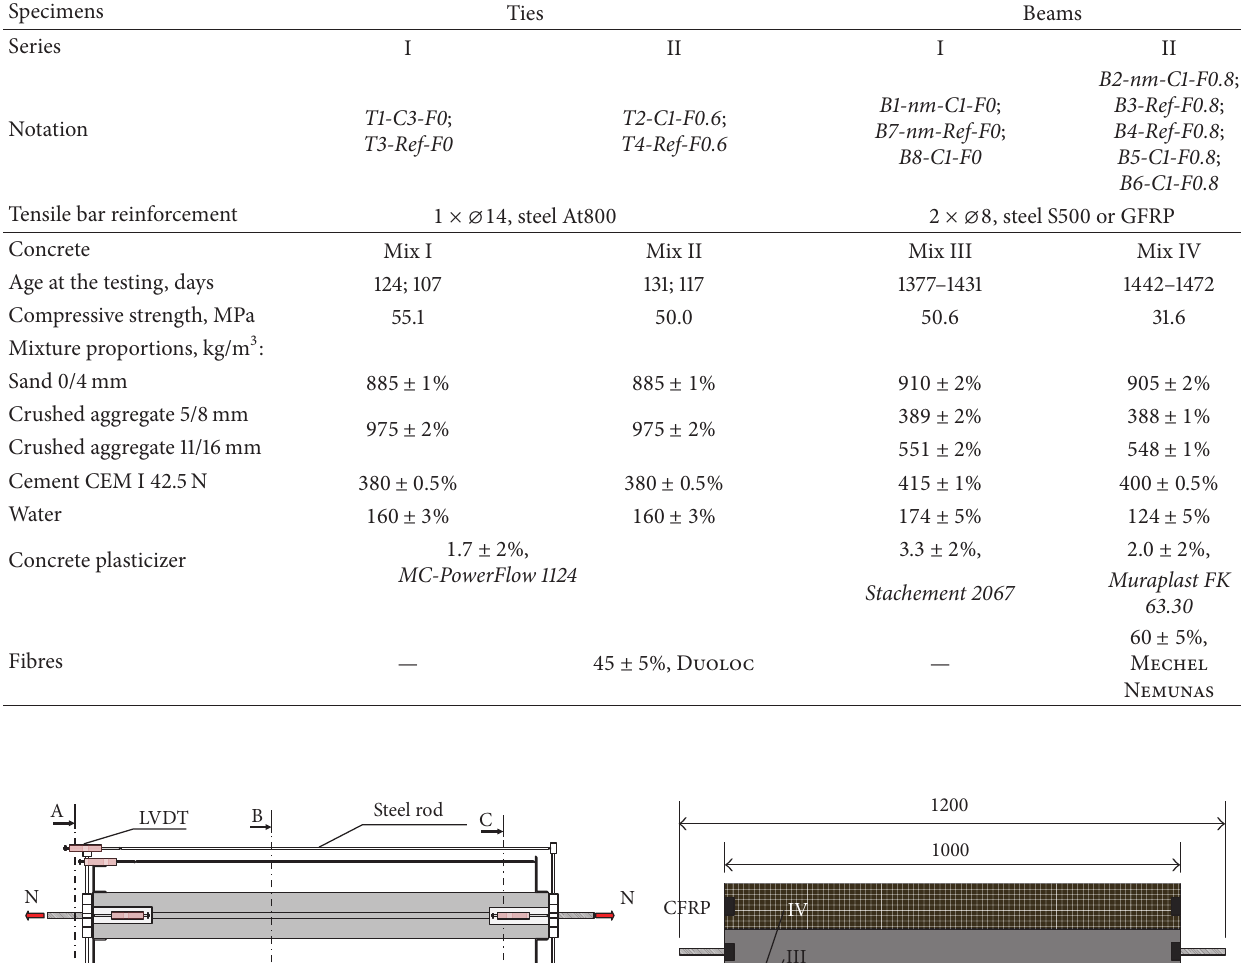
Table 1: Main characteristics and mix proportions of the experimental specimens.